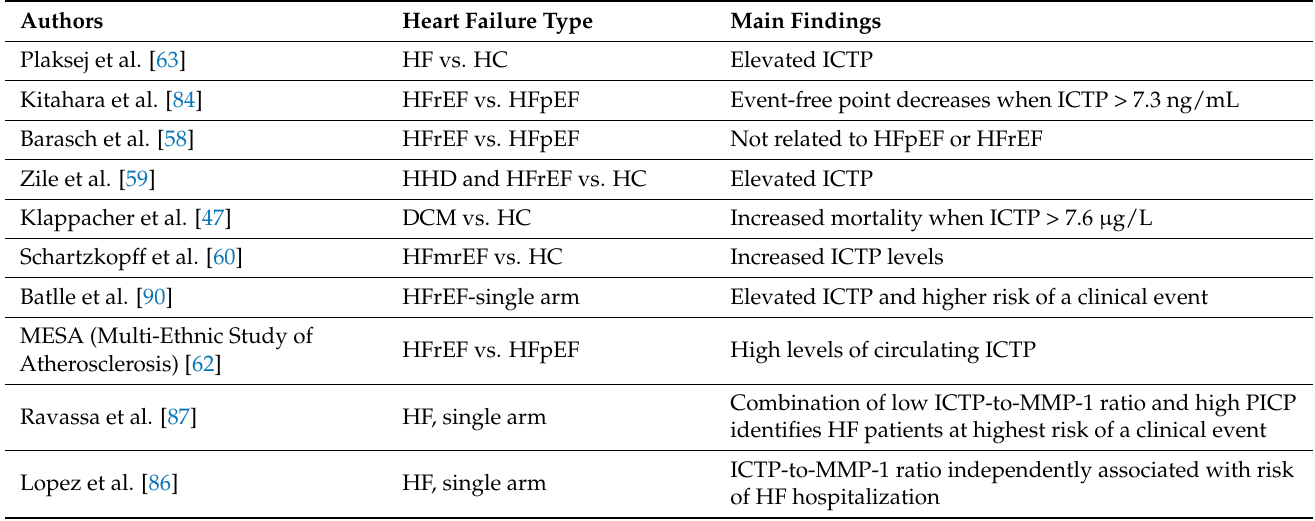
Table 3. Serum levels of ICTP in patients with heart